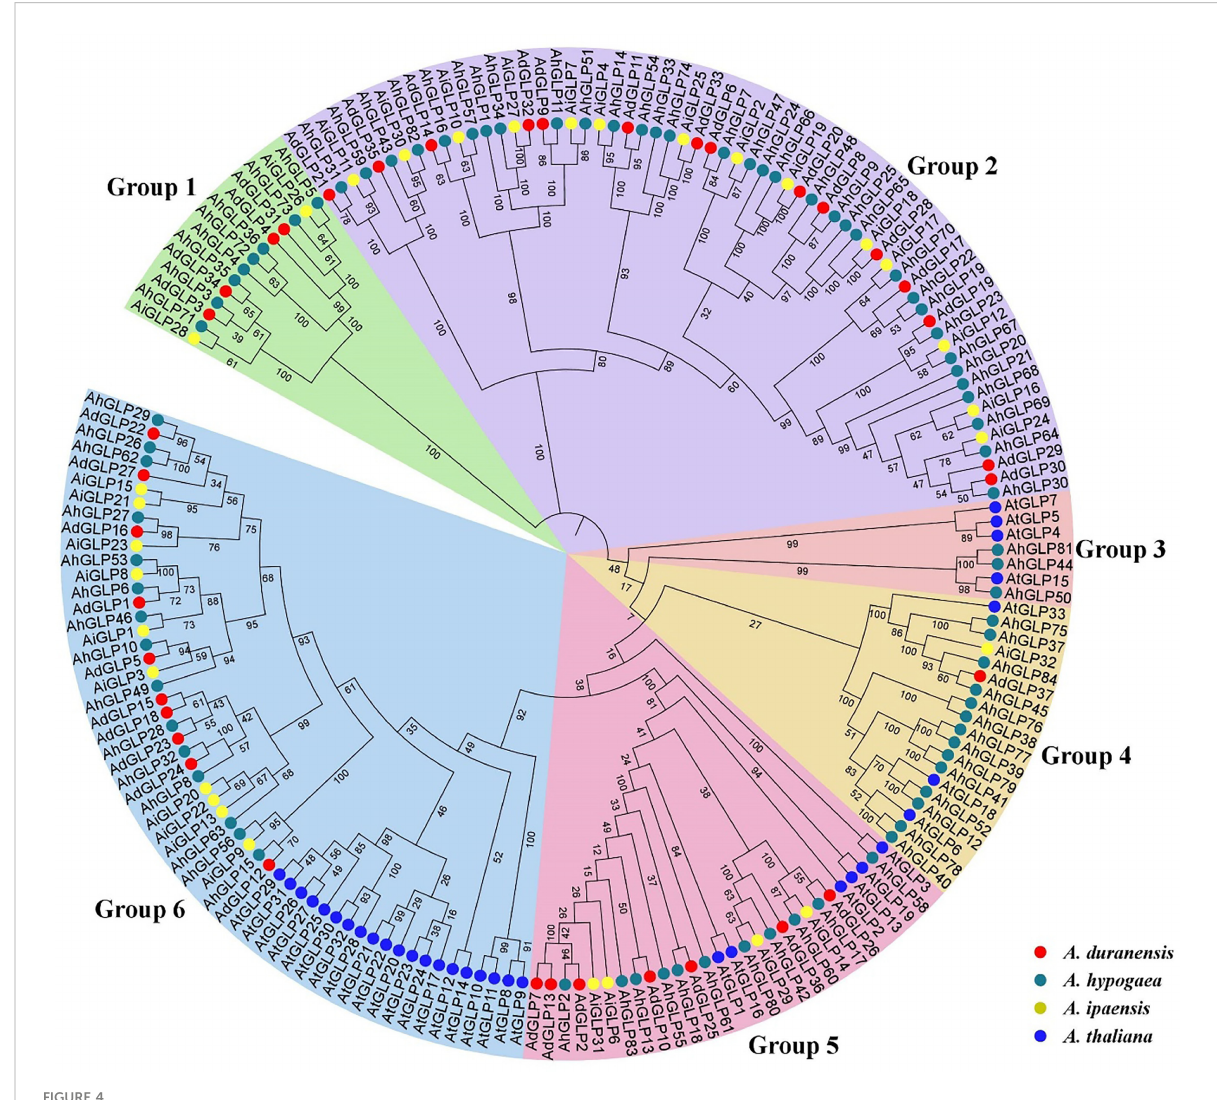
FIGURE 4 Phylogenetic relationships of Germin-like proteins of A. hypogea , A. duranensis , A. ipaensis , and A. thaliana . The phylogenetic tree classi fi ed peanut GLPs into six groups, while AtGLPs were restricted to only four groups. Germin-like proteins of cultivated peanut are phylogenetically closer to its wild parents as compared to Arabidopsis